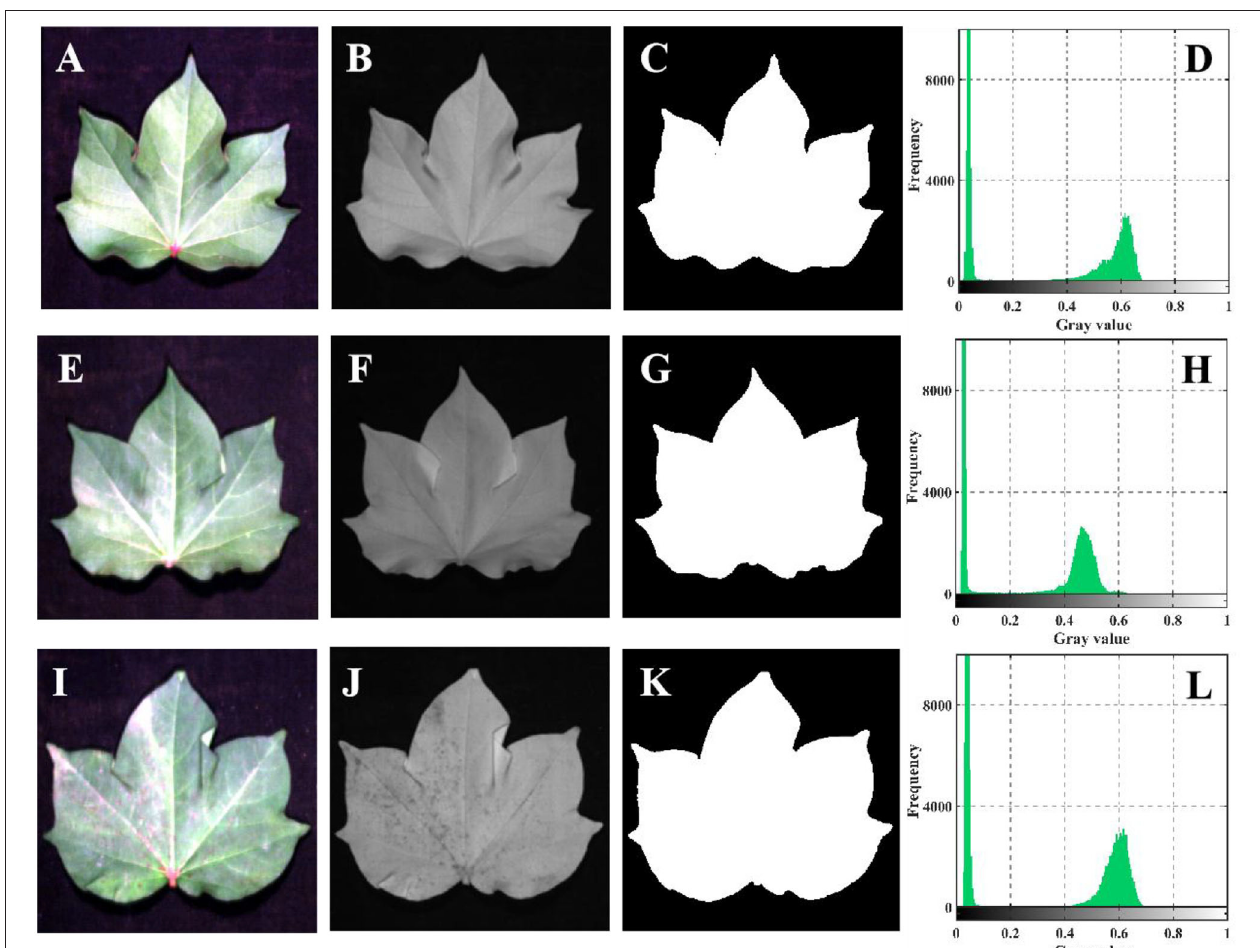
FIGURE 3 | ROI extraction process by single band threshold segmentation. (A–D) Budding stage. (E–H) Flowering stage. (I–L) Boll setting stage. (A,E,I) The true color picture synthesized by ENVI cannot completely represent the true color of leaf. (B,F,J) The grayscale image of 800nm. This grayscale image can display the outline of cotton leaves more completely in terms of brightness and clarity, so 800nm is selected as the segmentation band. (C,G,K) Mask image. (D,H,L) Gray histogram.